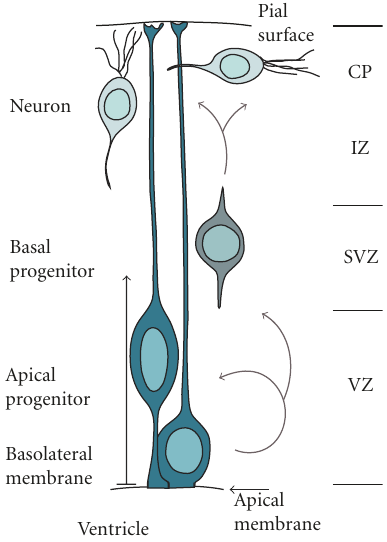
Figure 1: Scheme representing cell types in the developing mammalian cortex with (from top to bottom) neurons, basal (BP), and apical (AP) progenitors forming the cortical plate (CP), intermediate (IZ), subventricular (SVZ), and ventricular (VZ) zones, respectively. Lineages are depicted (arrows). Note the distinction between apical and basolateral plasma membrane of AP establishing the apicobasal polarity of the developing